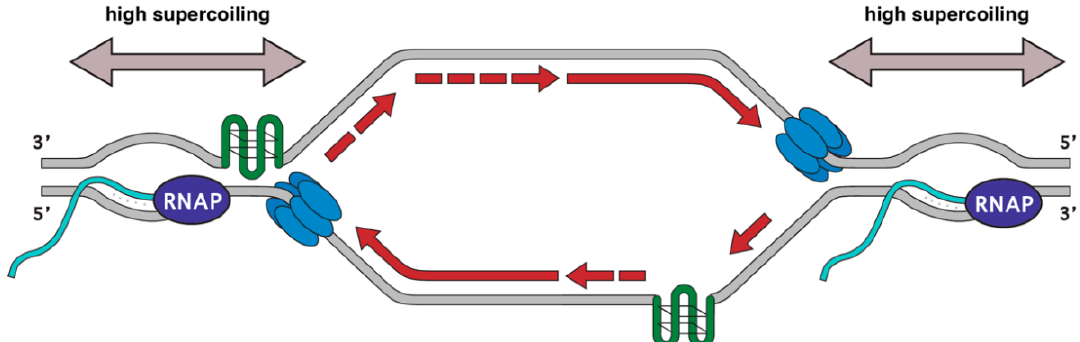
Figure 1. Factors influencing transcription-replication interactions. The orientation of RNAP, secondary structure formation, and DNA topology strongly influence the impact of transcription on replication-associated genome instability. A bidirectional replication origin is in the center with the left replication fork moving toward a convergent RNAP and the right fork moving toward a codirectional RNAP. TRIs are enriched for multiple factors associated with replication stress, including R-loops (turquoise) and DNA sequences forming G-quadruplex (G4, green) structures. R-loops themselves may pose a roadblock for replication but may also tether RNAP to the template strand. Duplex unwinding by the MCM2-7 helicase (blue) or RNAP (violet) can lead to excessive supercoiling ahead of the replication fork requiring topoisomerase activity to relieve torsional strain. Genomic regions with multiple replication destabilizing factors likely increase the chances for fork stalling/collapse, whether they occur on opposite strands (left) or sequentially (right).